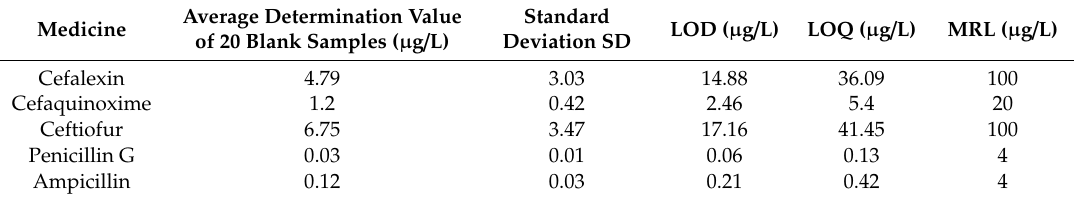
Table 2. Limits of detection (LODs) and limits of quantitation (LOQs) of beta-Lactam antibiotic in milk